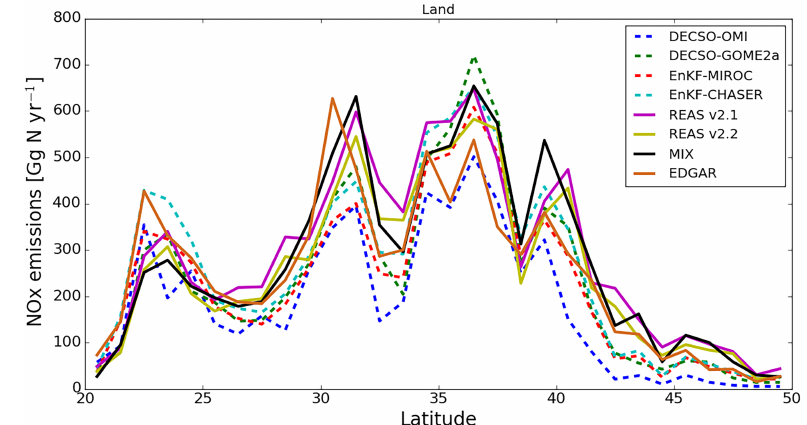
Figure 7. Latitudinal distribution of longitudinal total NO x emissions over land. The emissions are summed over a 1 ◦ longitudinal band above land.